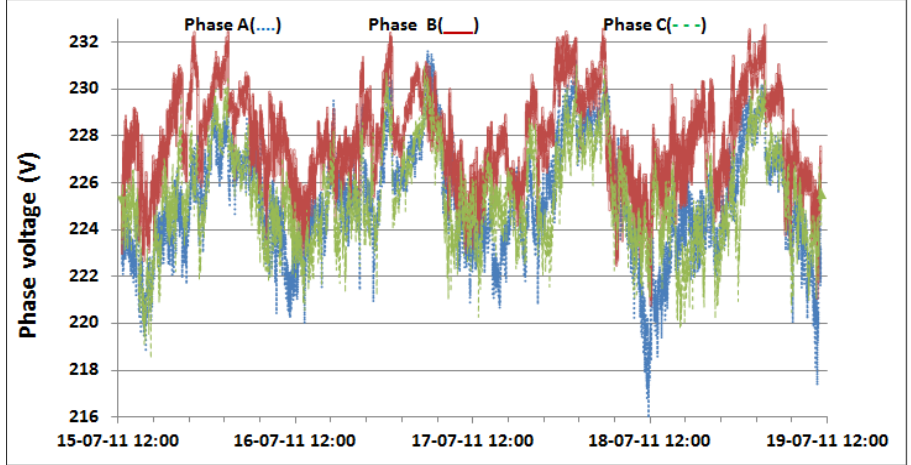
Figure 16. Phase voltage oscillations for 15–19